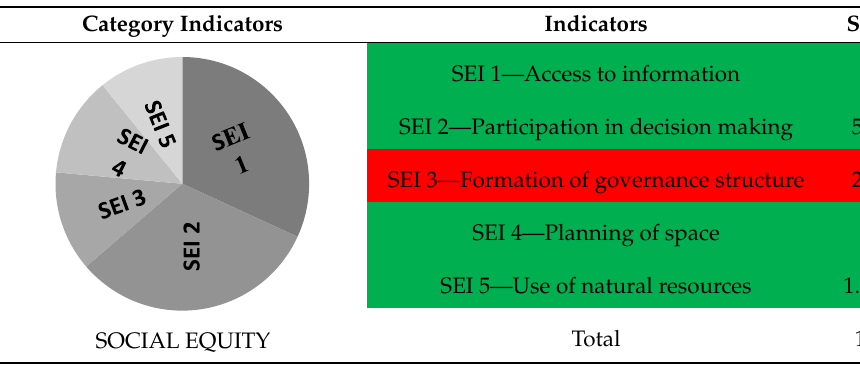
Table 8. RAG rating of Social Equity Indicator in Louroujina.